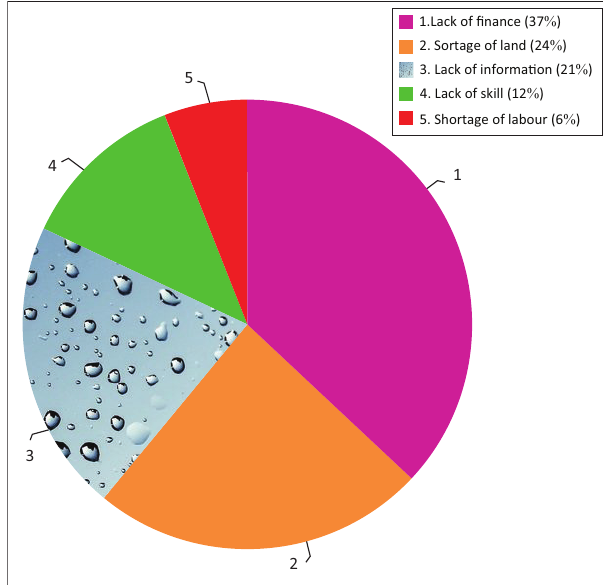
FIGURE 3 : Barriers to climate change adaptation in the study